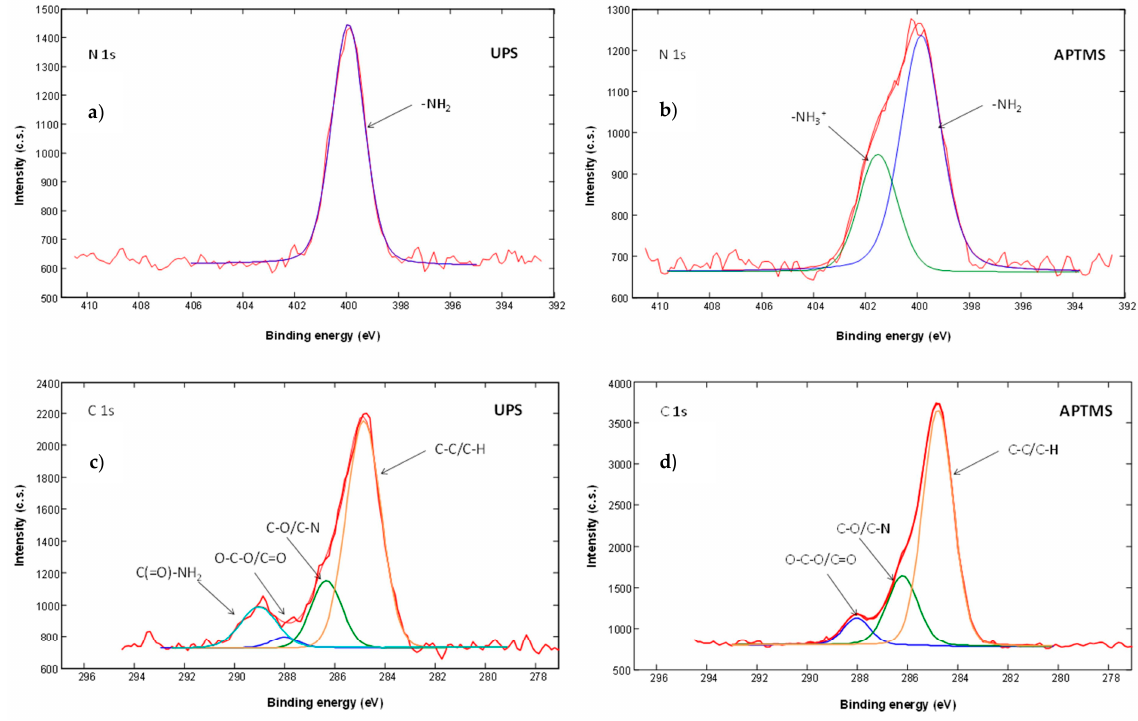
Figure 4. ( a ) High-energy resolution N1s XPS spectra from UPS, ( b ) APTMS modified sensor surface, ( c ) High-energy resolution C 1s XPS spectra from UPS and ( d ) APTMS modified sensor surface.